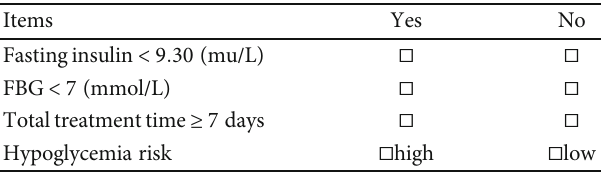
Figure 1: ROC curve of hypoglycemia probability in patients. Table 4: Hypoglycemia risk assessment form for intensive insulin treatment of